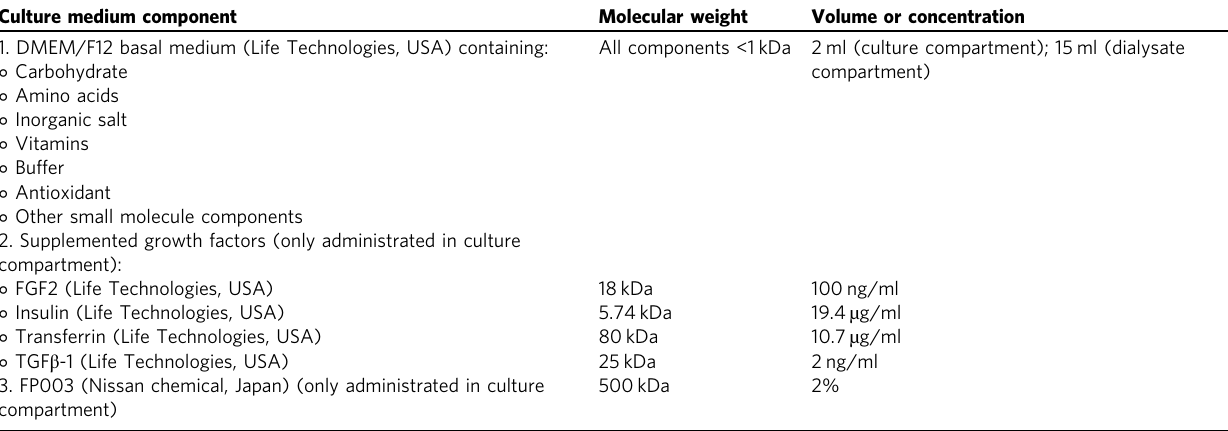
Table 1 The medium formulation used in this study. Culture medium component Molecular weight Volume or